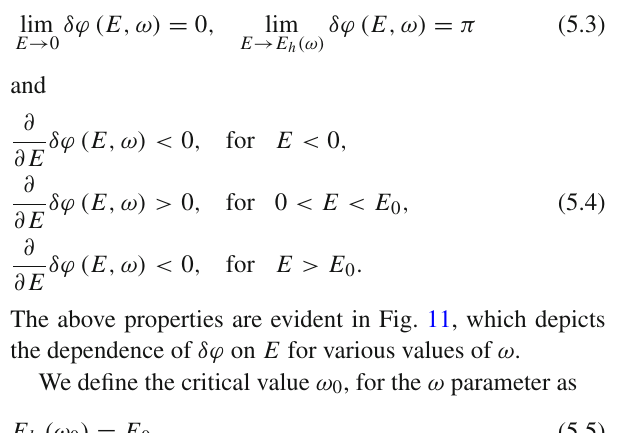
Fig. 10 The conical minimal surface in global and Poincaré coordi- nates